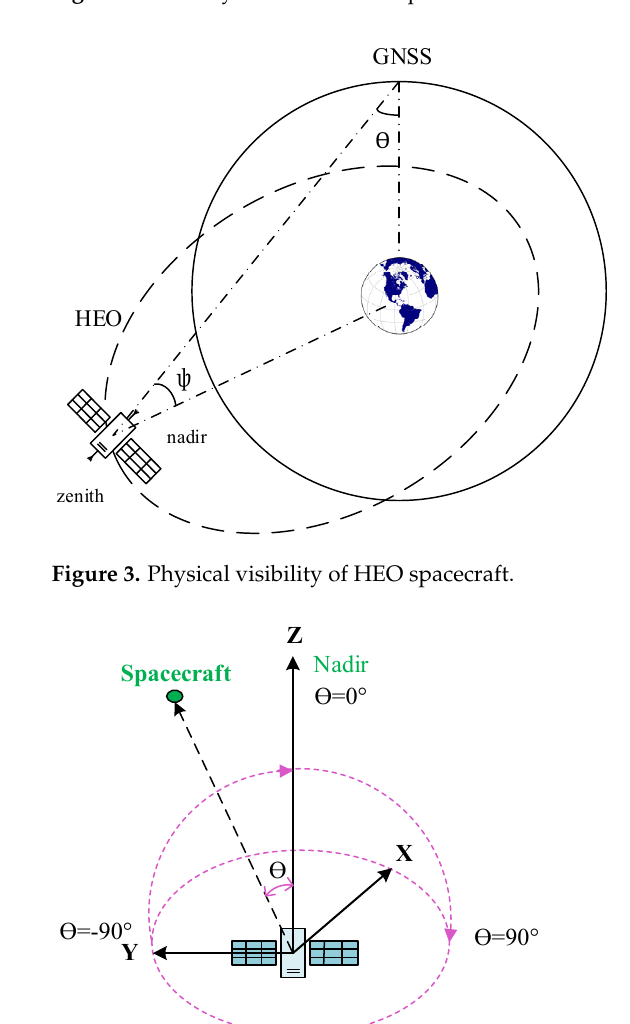
Figure 2. GNSS symmetric antenna patterns.